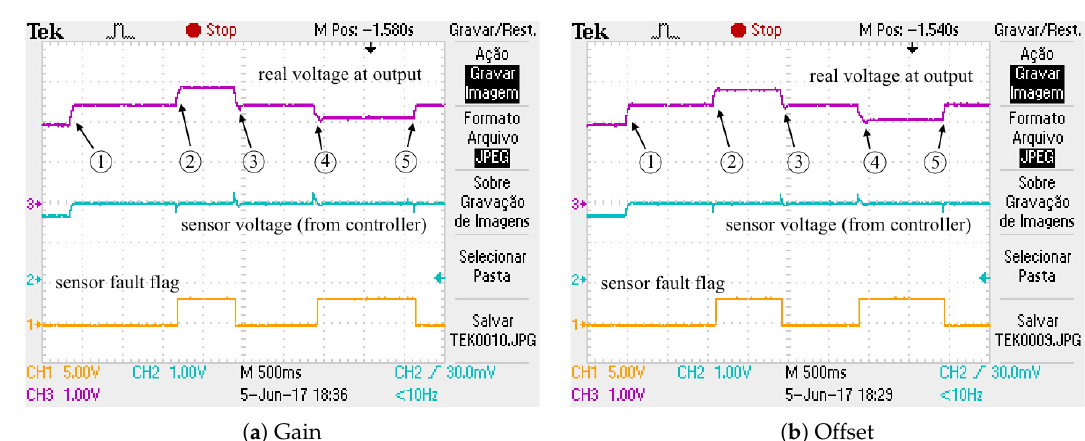
Figure 16. Experimental detection and isolation of faults in voltage sensor.